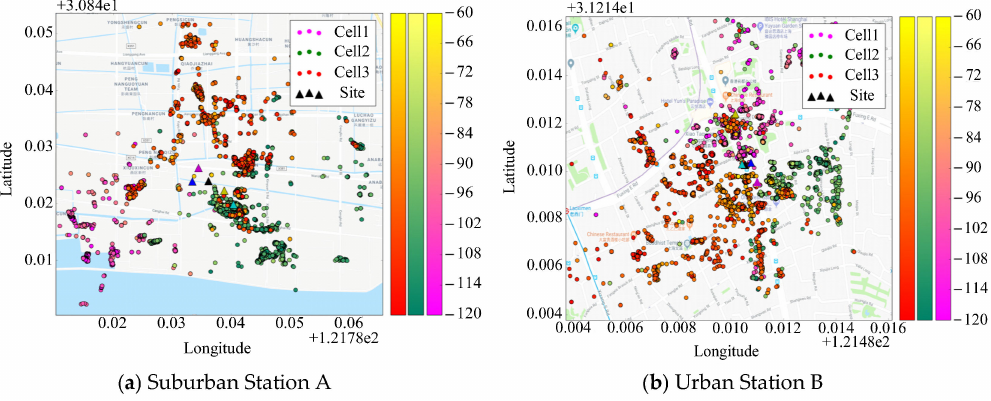
Figure 9. Comparison of BS location